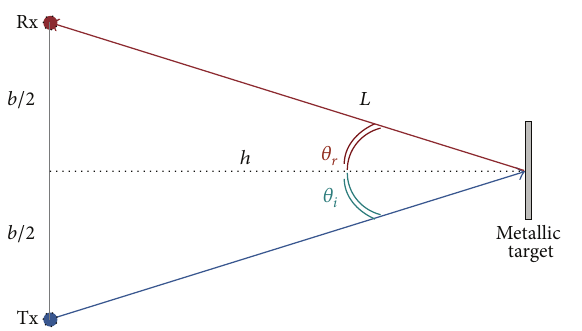
Figure 7: Geometry setup for single target detection measurement. For ranges 1 and 2, 𝑏 = 2.25 m, ℎ = 14.22 m, 𝐿 = 14.4 m, and 𝜃 𝑖 = 4.45 ∘ ; for range 3, 𝑏 = 3.35 m, ℎ = 31.07 m, 𝐿 = 37.6 m, and 𝜃 2.55 ∘ .